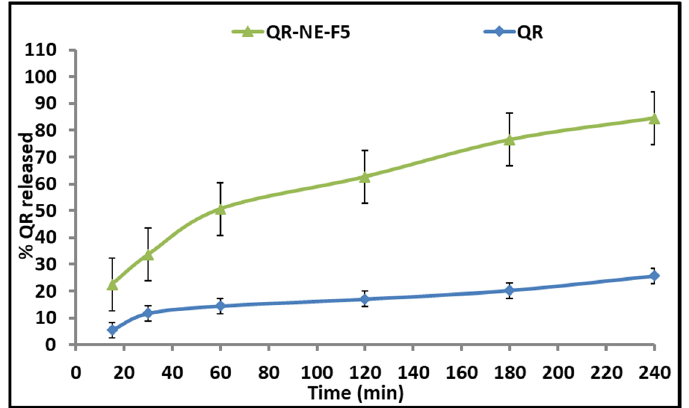
Figure 5. The cumulative released amount of quercetin (QR) and the selected formula (QR-NE-F5).